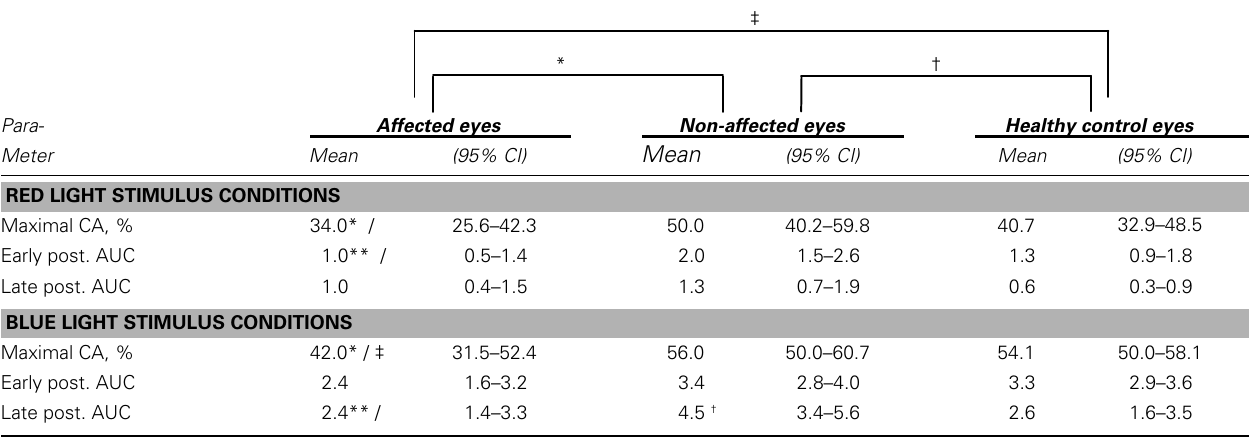
Table 2 |The pupil responses to red and blue light for the affected eyes of patients with unilateral NAION, the non-affected eyes in the same patients and a group of age-matched, healthy